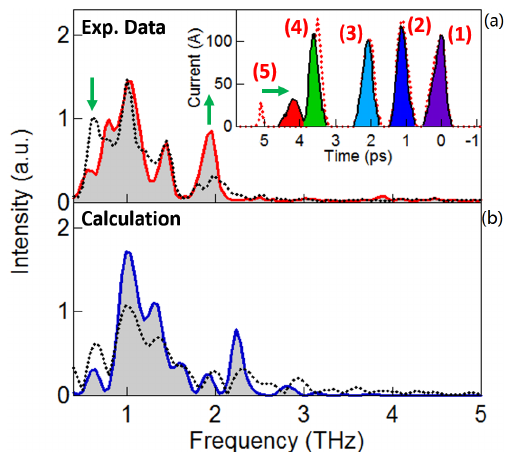
Figure 6. THz generation by a five comb beam reducing the inter-distance of the last two bunches from 1.6 ps to 0.6 ps. ( a ) Measured spectrum is shown through red curve is compared to that obtained with 1.6 ps of inter-distance (black dotted curves); ( b ) Numerical calculation from measured current distributions reported in the inset: inter-distance 0.5 ps (blue curve) and inter-distance 1.6 ps (black dotted curve).